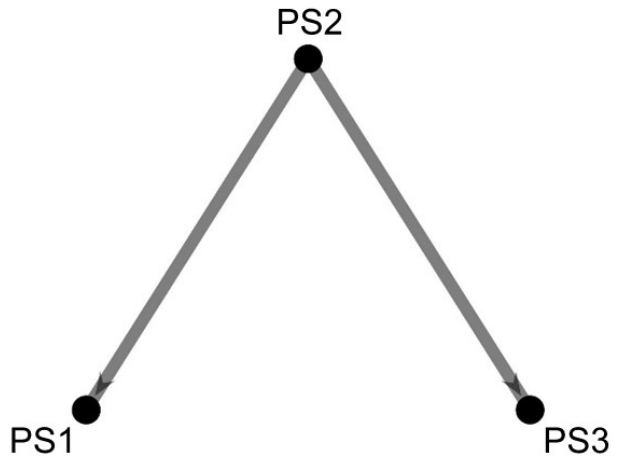
Figure 8. PS-PC1 plant-wide causality map, produced in the first stage of the hierarchical approach. The root cause is a faulty valve located in PS2. Edge weights represent magnitude of causal influence (measured by the G-causality index defined in Section 2.1).